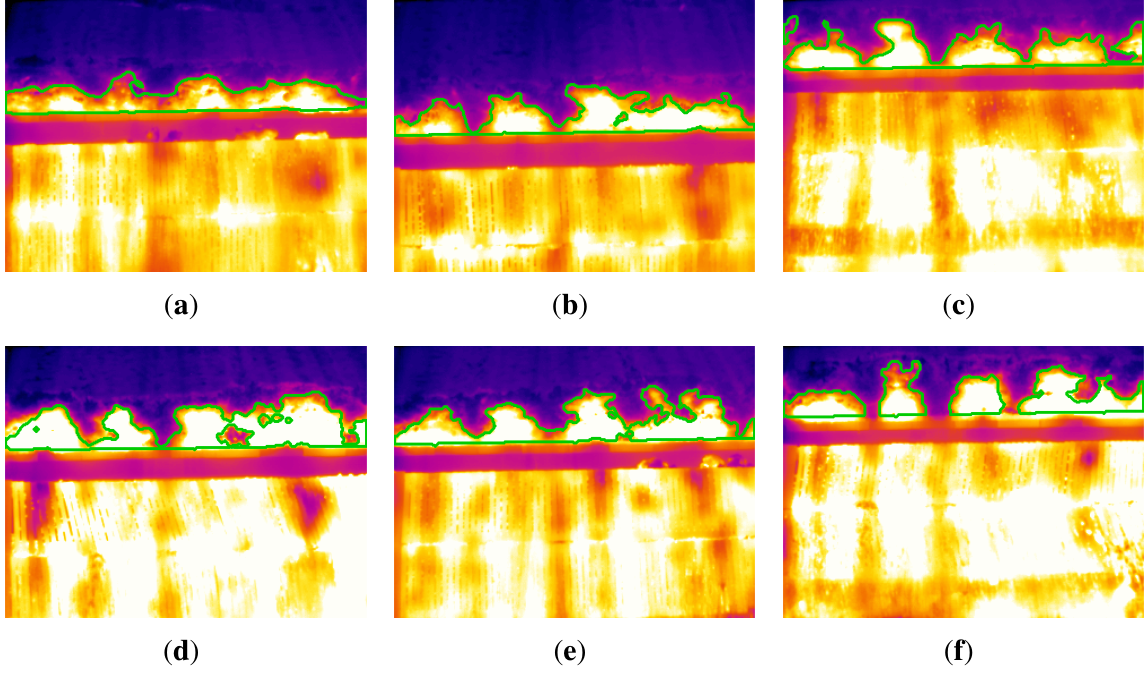
Figure 14. Results for the segmentation of the flame front in all key frames. ( a ) Frame